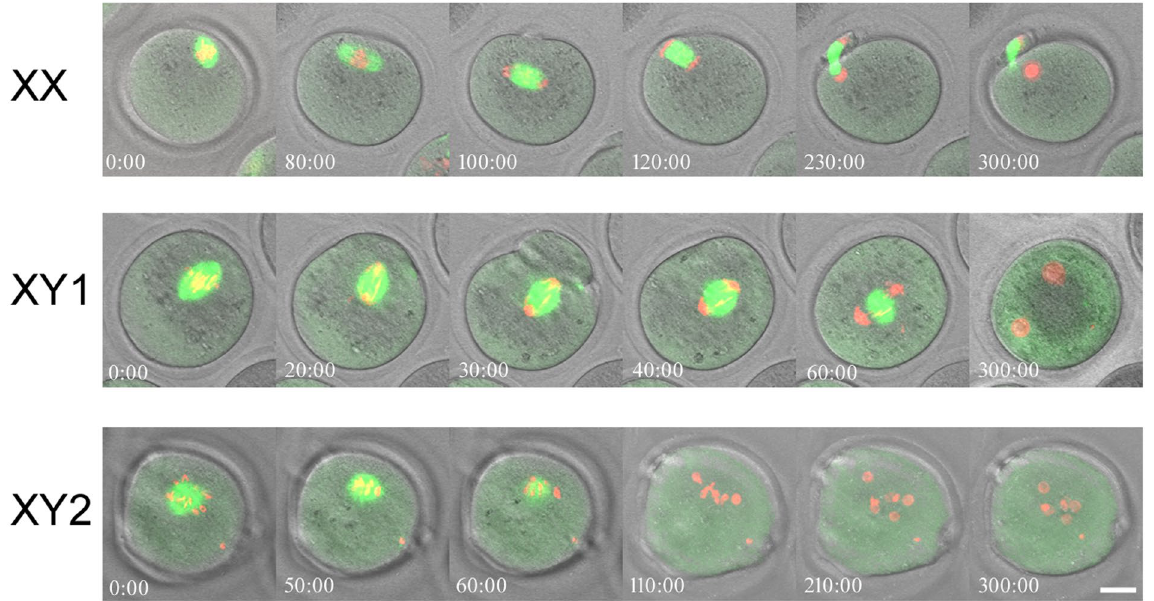
Figure 6. Spindle movement and sister chromatids segregation in the MII-oocytes from XX and XY females following parthenogenic activation. Meiotic spindles and chromosomes were visualized by injection of β 5- tubulin-GFP and H2B-mCherry mRNAs into the GV-stage oocytes, followed by IVM. The images of oocytes from XY females were compressed from Z-stacks in order to capture the entire chromatids or pronuclei. Bar: 20 µ m. (The time-lapse videos were given in Supplementary Fig. S3.1–S3.3.) The experiments were repeated at least three times each. Total 7 oocytes (1 or 2 oocytes at a time) were tested for each